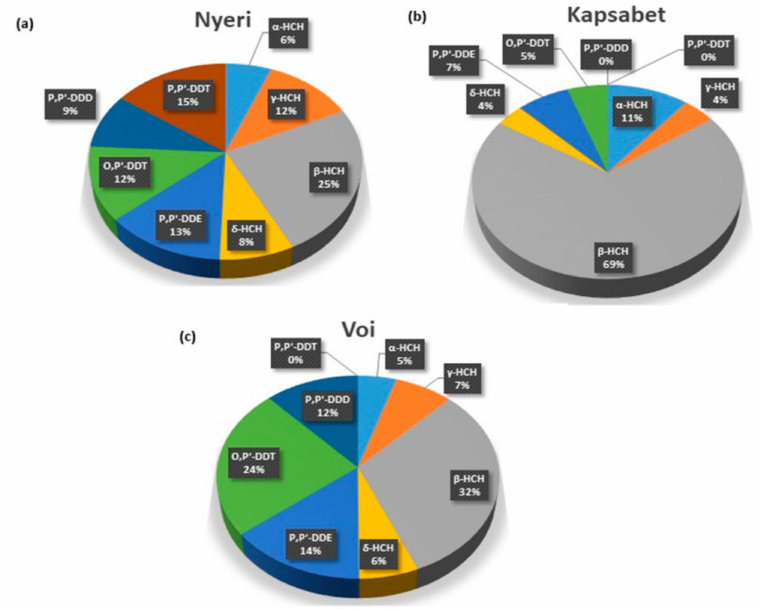
Figure 2. Pie charts showing the proportions and spatial distribution of DDTs and HCHs concentrations in ( a ) Nyeri, ( b ) Kapsabet, and ( c ) Voi towns in